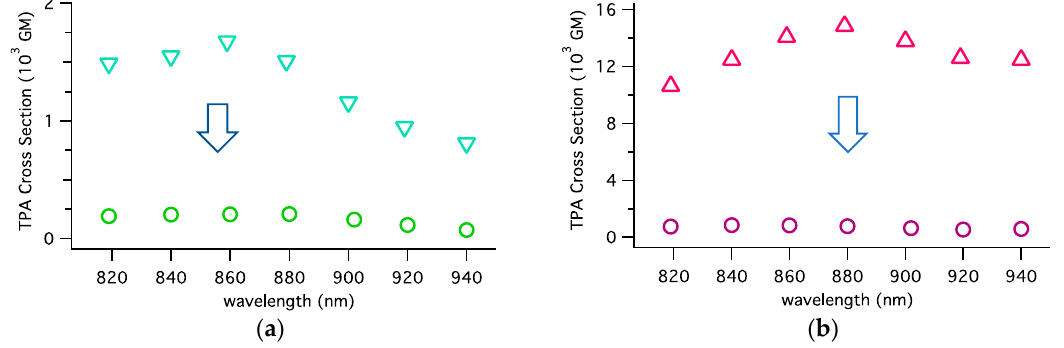
Figure 4. Open aperture Z-scan traces of Ru-2 in dichloromethane at 960 nm ( a ) without and ( b ) with stirring sample, and ( c ) the comparison of the same data. The arrows in Panels ( a ) and ( c ) show the scanning directions. ( d ) The trace of the known sample that only shows two-photon absorption (MPPBT / DMSO, see Section 4). The incident power was 0.4 mW.